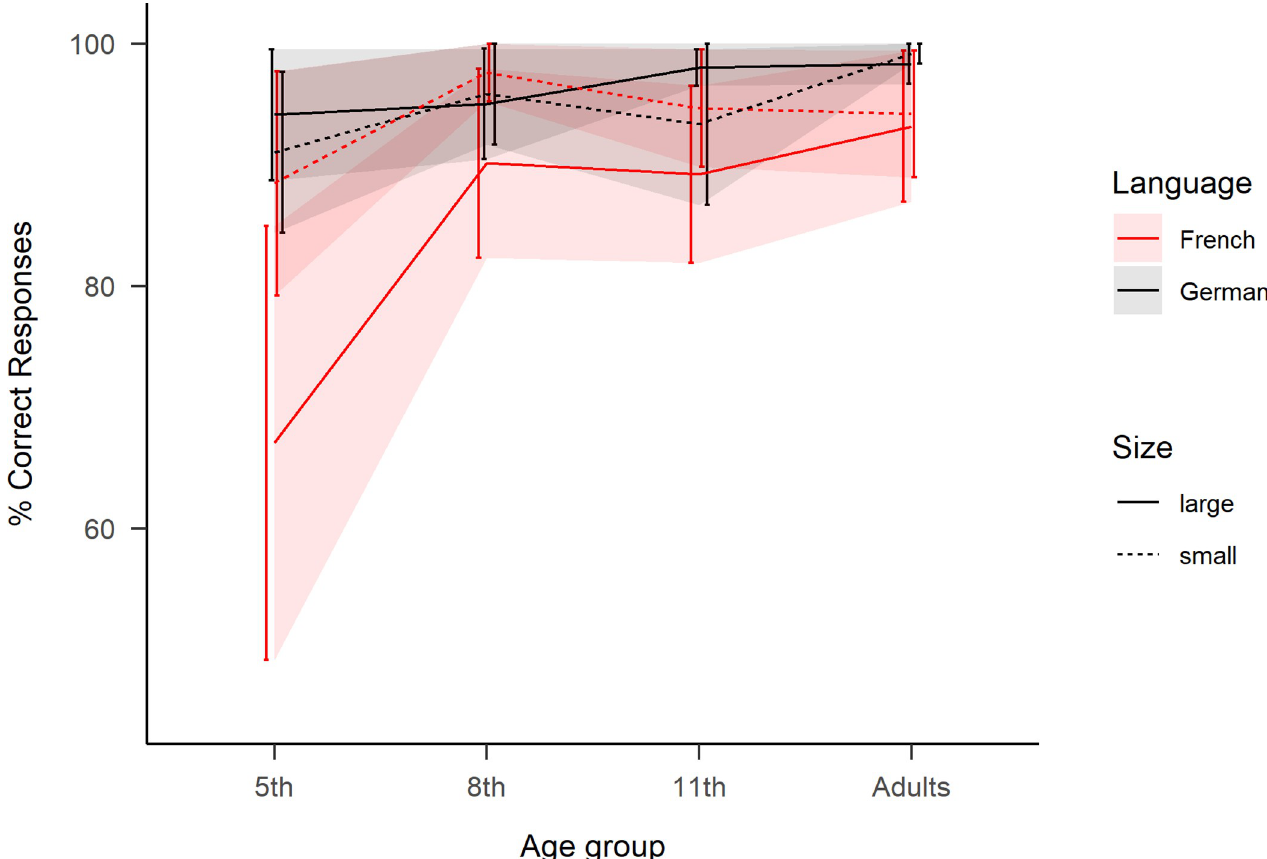
Fig 7. Correct Responses in the reading aloud task. Percent correct for each age group as a function of “Language” and “Number Size”. Large numbers correspond to ‘70s, ‘80s and ‘90s, while small numbers correspond to ‘30s, ‘40s and ‘50s. Ribbons represent standard error.